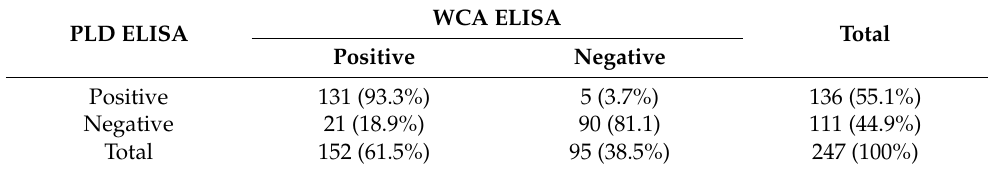
Table 5. Serological testing of alpacas originating from herds A, B and C using a commercial enzyme- linked immunosorbent assay (ELISA) based on a phospholipase D antigen (PLD ELISA) and an in-lab ELISA using a whole cell antigen (WCA ELISA). Serum samples from a total of 232 animals were tested. PLD ELISA WCA ELISA Herd Positive Negative Positive Negative Total A 110 (62.9%) 65 (37.1%) 124 (70.9%) 51 (29.1%) 175 (75.4%) B 8 (20.5%) 31 (79.5%) 8 (20.5%) 31 (79.5%) 39 (16.8%) C 12 (66.7%) 6 (33.3%) 10 (55.6%) 8 (44.4%) 18 (7.8%) Total 130 (56%) 102 (44%) 142 (61.2%) 90 (38.8%) 232 (100%) Table 6. Comparative serological testing of samples taken from alpacas originating from herds A, B and C using a commercial ELISA based on a phospholipase D (PLD ELISA) and an in-lab ELISA using whole cell antigen (WCA ELISA). A total of 247 serum samples from 232 alpacas were tested. WCA ELISA PLD ELISA Total Positive Negative Positive 131 (93.3%) 5 (3.7%) 136 (55.1%) Negative 21 (18.9%) 90 (81.1) 111 (44.9%) Total 152 (61.5%) 95 (38.5%) 247